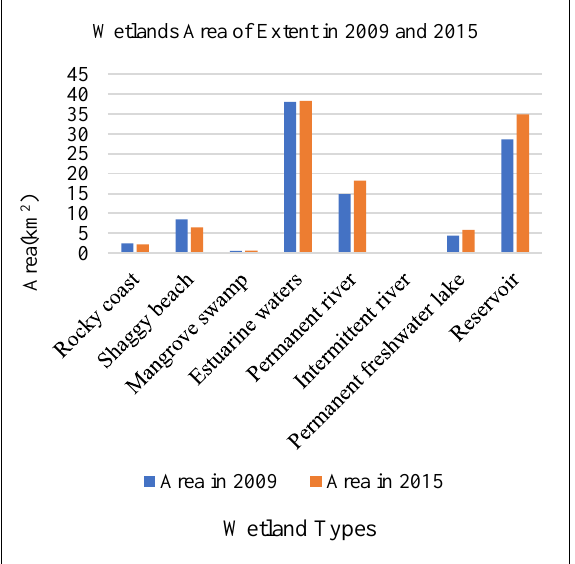
Figure 2. Changes in Area of Wetland in the Study Region